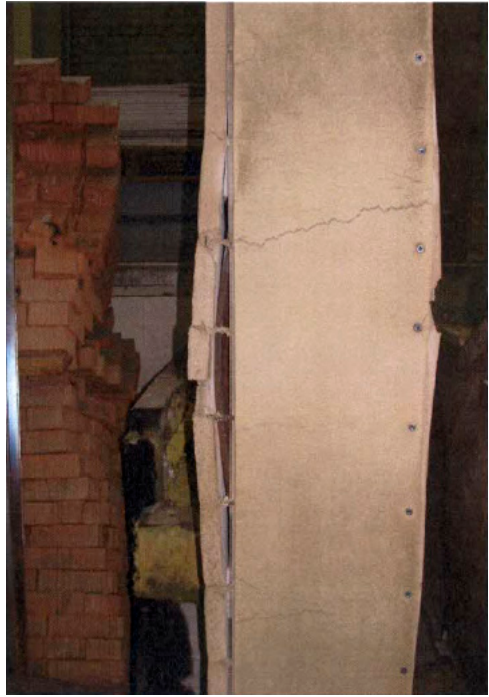
Figure 14. Vertical deformation of the column engineering prototype, hydrocarbon fire.